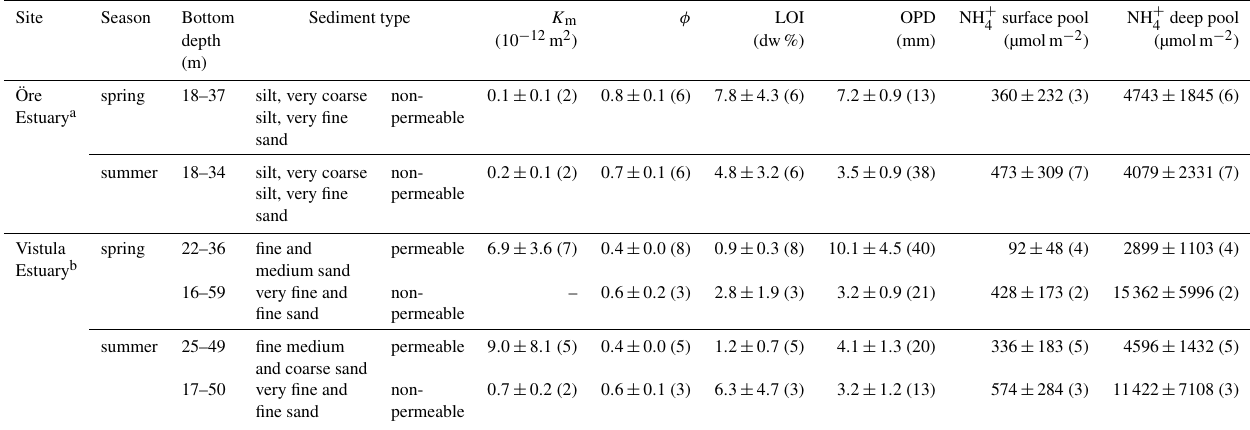
Table 3. Sediment characteristics in the Öre and Vistula estuaries in spring and summer. Permeability ( K m ), porosity ( φ ), and loss on ignition (LOI) are determined from the pooled surface sediment (0–2cm); NH + pools are derived from vertically integrated pore-water concentrations 4 over the surface (0–2cm) and the subsurface (2–10cm) sediment layer; oxygen penetration depth (OPD) is derived from oxygen profiles. All data are given as average and standard deviation (except for bottom depth), with the number of replicates in